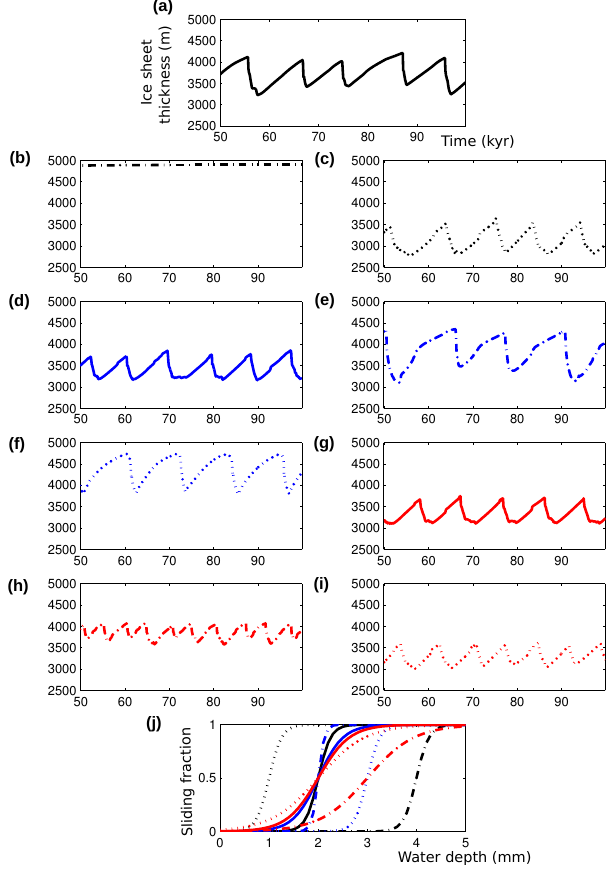
Figure 10. Sensitivity to the parameters ( a ) and ( b ) in Eq. (1). The- ses values are presented in Table 2. Panels (a) – (i) show the sur- face height of the ice sheet averaged over the blue box in Fig 3. Panel (j) shows the sliding fraction, C from Eq. (1), as a function C o of water depth, for the different values. The parameter values in each panel are as follows: (a) a : 2.0mm, b : 0.8mm; (b) a : 4.0mm, b : 0.8mm; (c) a : 1.0mm, b : 0.8mm; (d) a : 2.0mm, b :